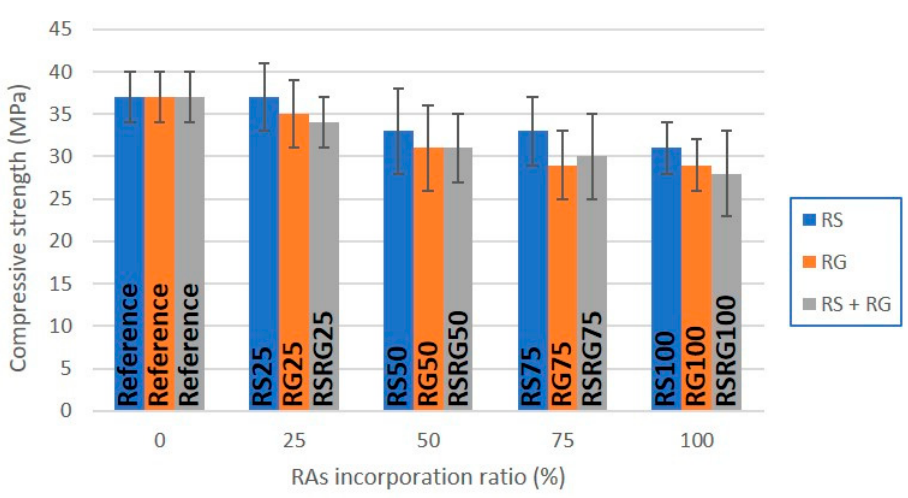
Figure 2. Characteristic compressive strength at 28 days for cylindric test specimens prepared with RAs.